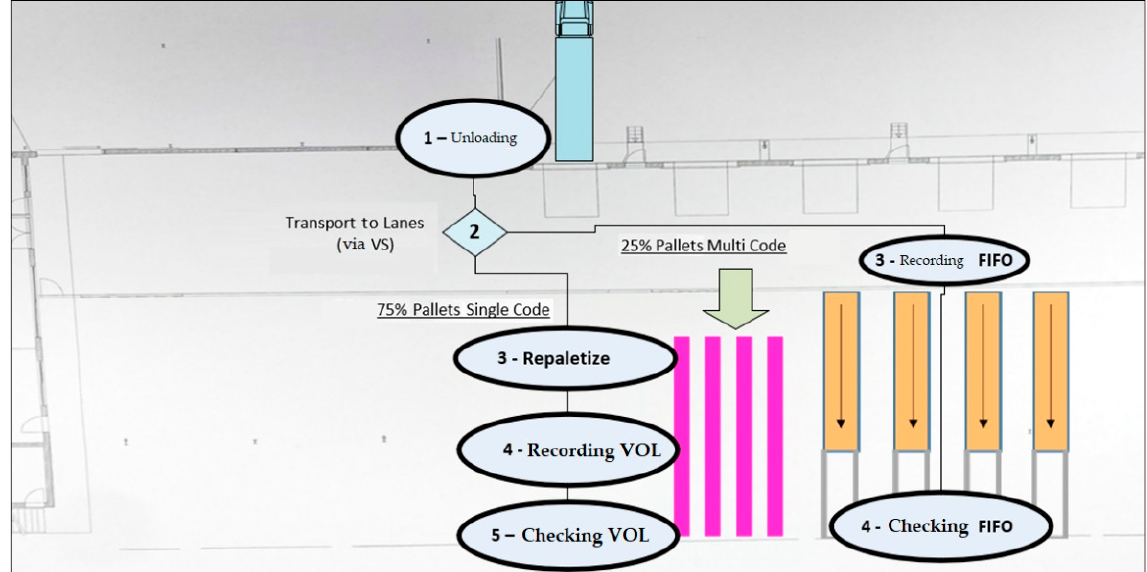
Figure 12. VSD Multi Code Pallets.